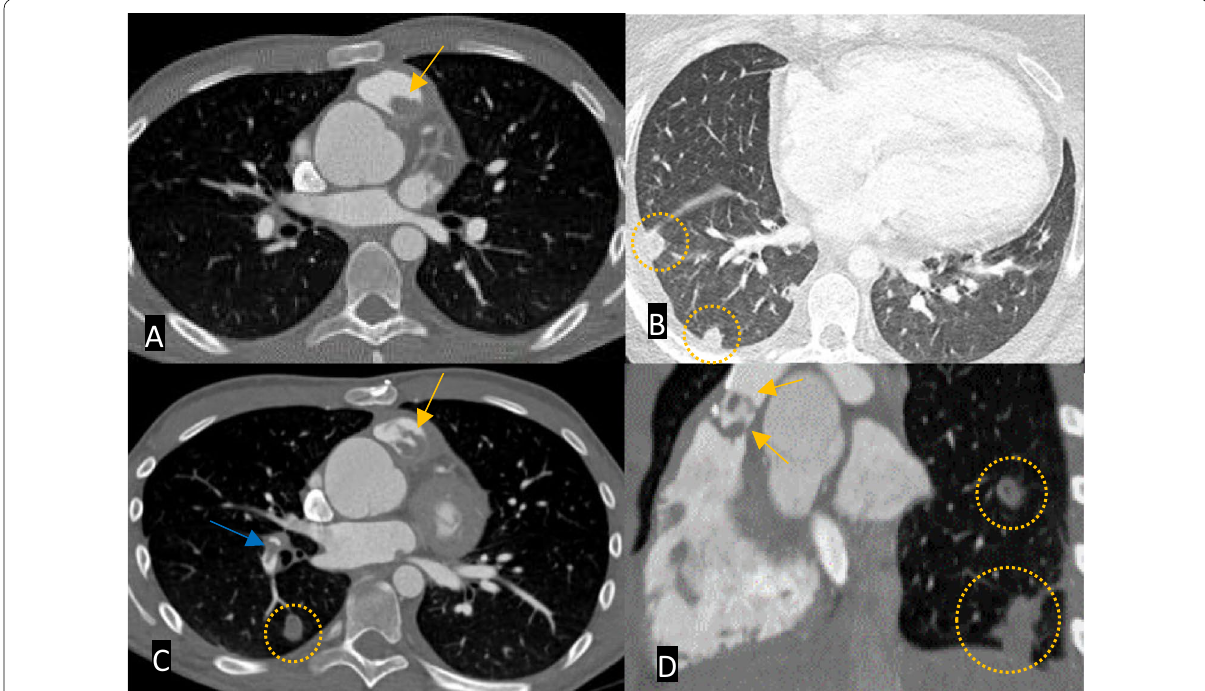
Fig. 12 Select multiplanar CT images showing a valved RV-PA conduit to treat RVOT obstruction. Axial images in the bone window ( A and C ), lung window ( B ) and MPR reformats in the sagittal plane ( D ), bone window. There are vegetations of the RV-PA conduit (orange arrows), septic emboli in the arteries of the right lower lobe (blue arrow) and pulmonary abscesses (dotted circles). RV: right ventricle; PA: pulmonary artery; MPR: multiplanar reconstruction; RVOT: right ventricular outflow